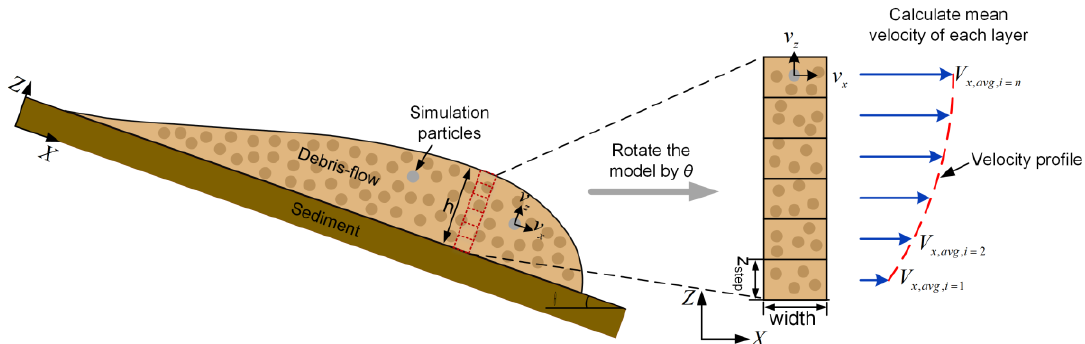
Figure 1. Illustration of particle stratification statistics method.